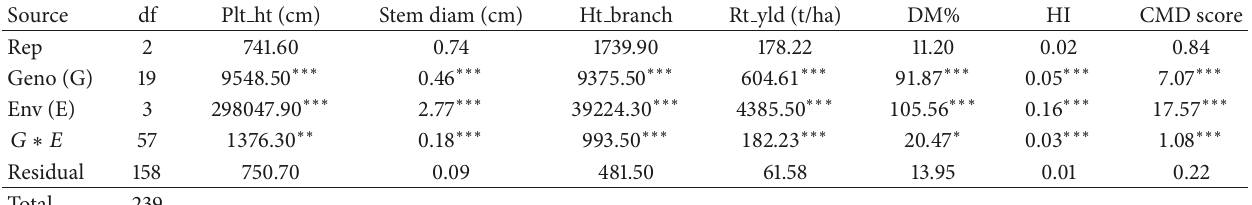
Table 3: Combined analyses of variance for seven traits evaluated on 20 cassava genotypes in two ecologies of Ghana. Source df Plt ht